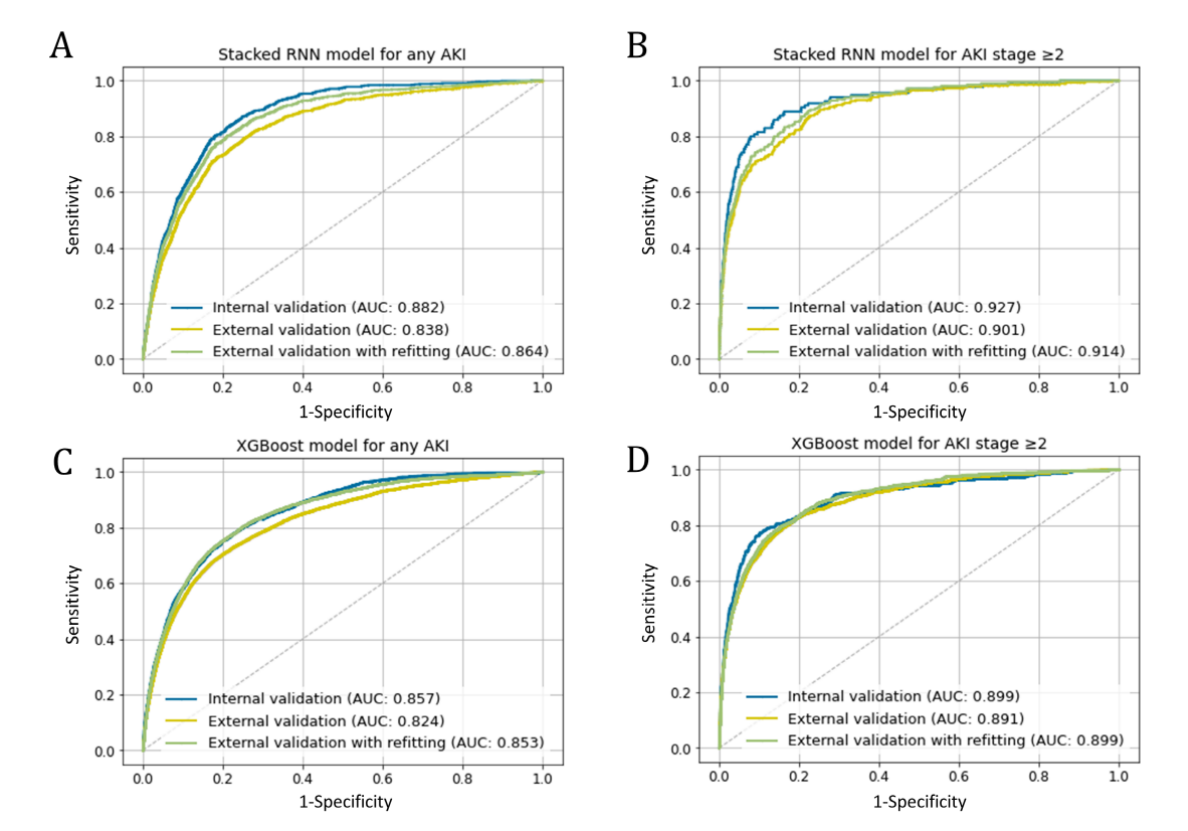
Table 2. Predictive performance of model 2 for the future value of serum creatinine (Cr).